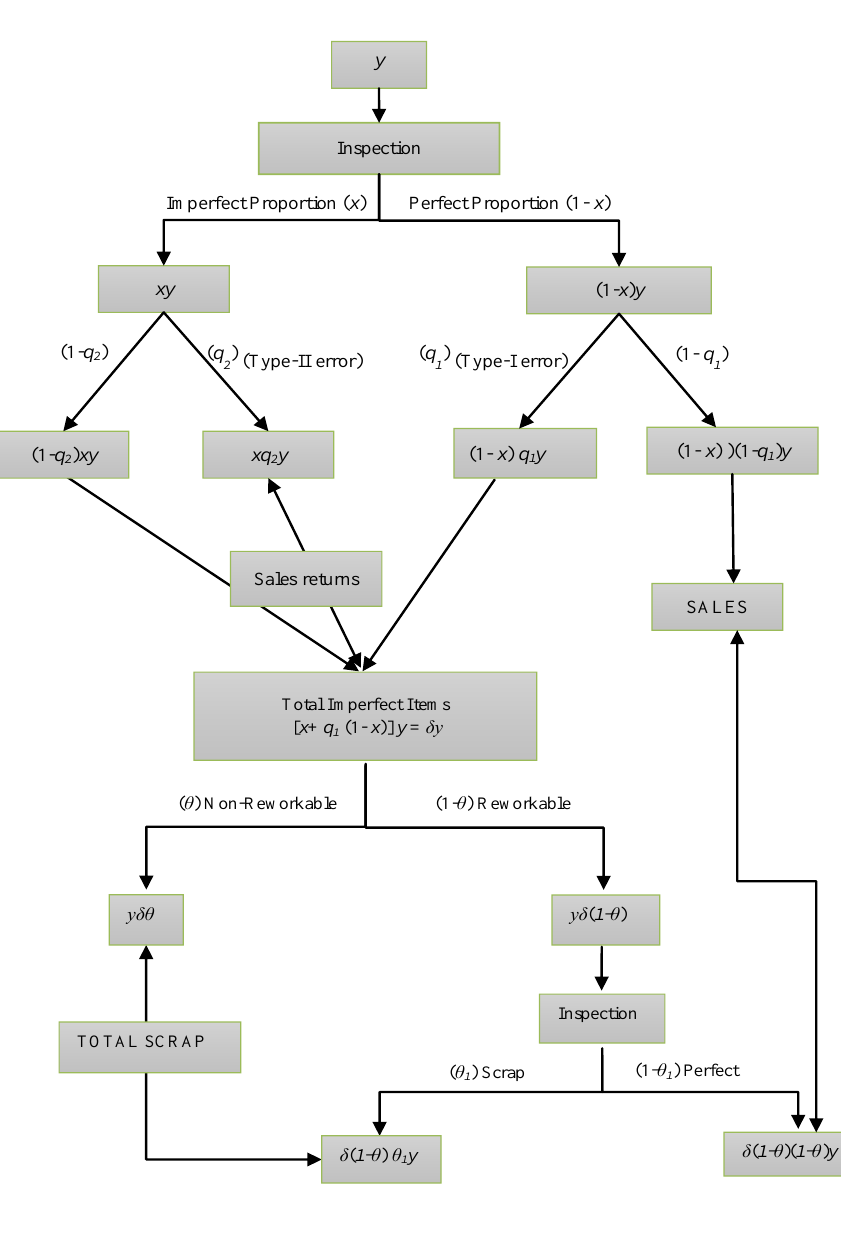
Fig. 1. Sequence of events in the inventory